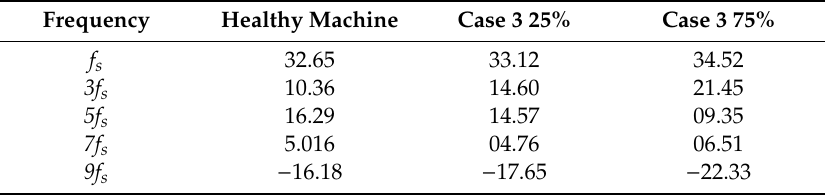
Table 3. Current harmonic components comparison due to case 3 (in